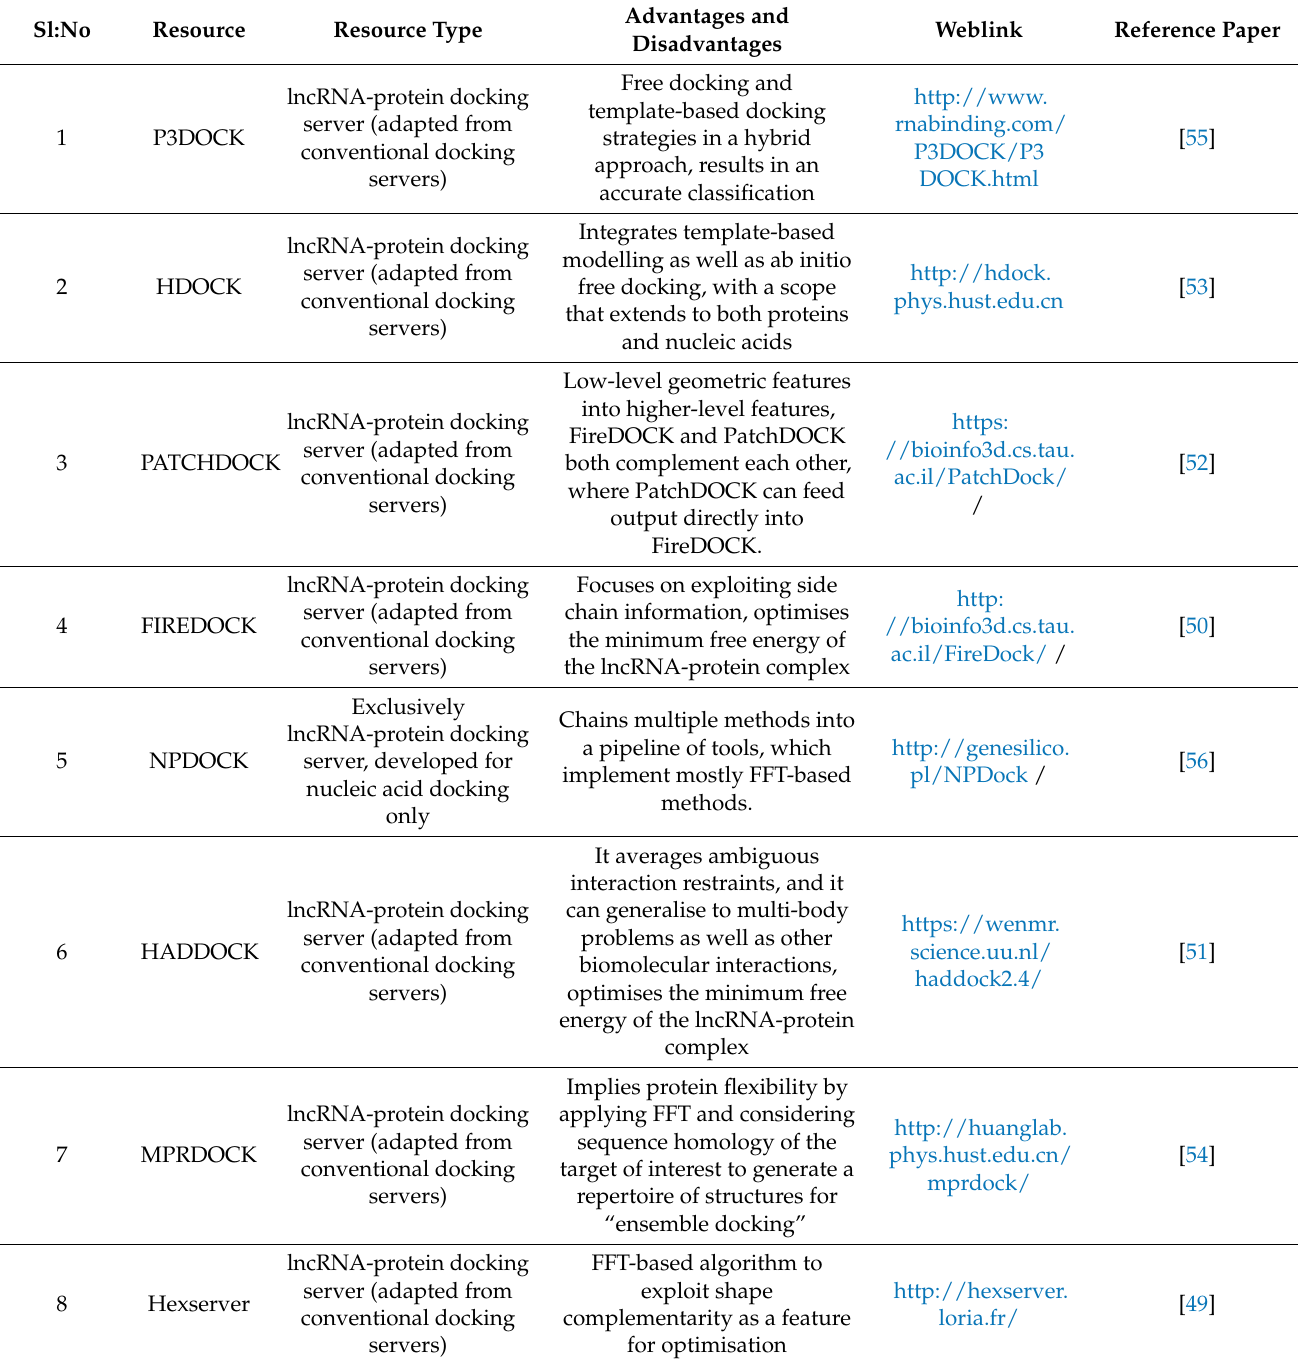
Table 1. A comparison of molecular docking tools used to predict lncRNA-protein interactions. Important attributes of these molecular docking tools, including their effectiveness and a link to their corresponding server, are listed (all weblinks are accessed on 27 May